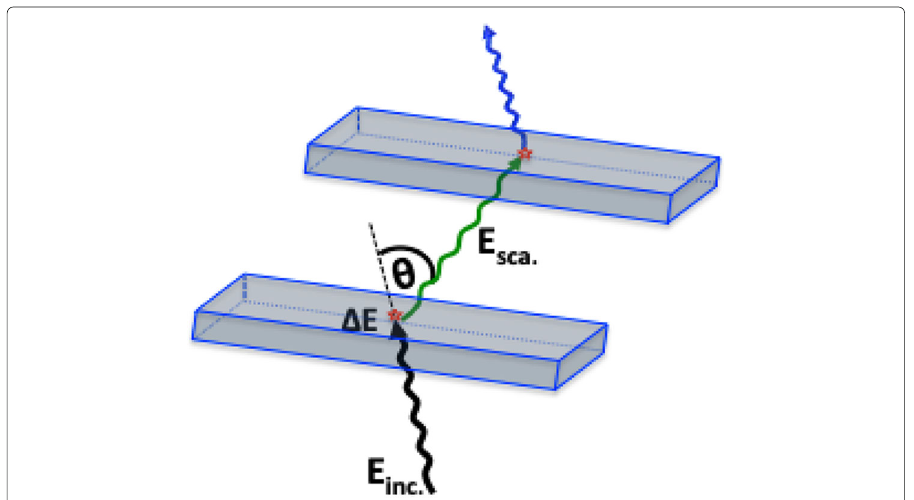
Fig. 5 The incoming and scattered photon interactions are presented with two exemplary scintillators. Knowing the positions of emission of E inc photon and positions of interactions of E inc and E sca photons inside the scintillators allow to estimate the scattering angle